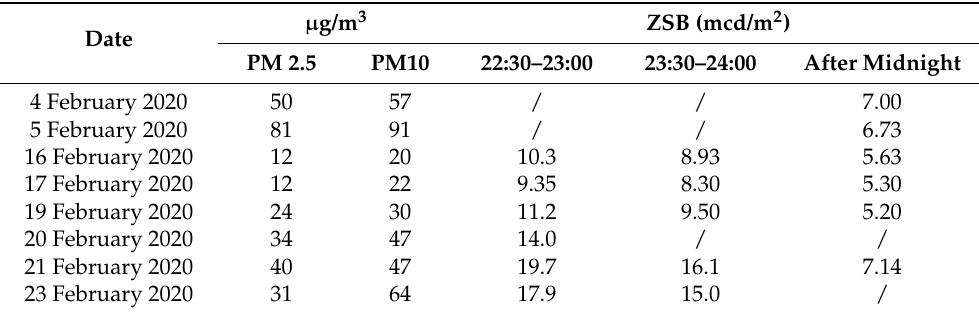
Table 5. Zenith sky brightness (ZSB) at the three time intervals of Guangbutun region versus concentrations of PM2.5 and PM10 particles for February 2020. Due to effects of the moon and the cloud cover, the brightness data were null for some